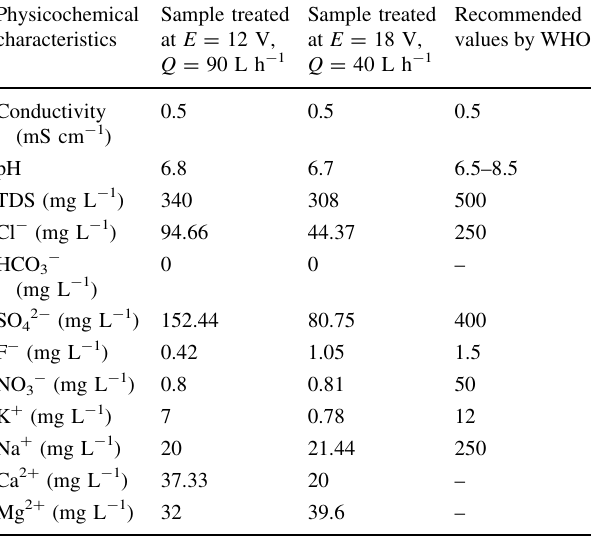
Table 8 Physicochemical characteristics of treated water Physicochemical Sample treated characteristics at E = 12 V,